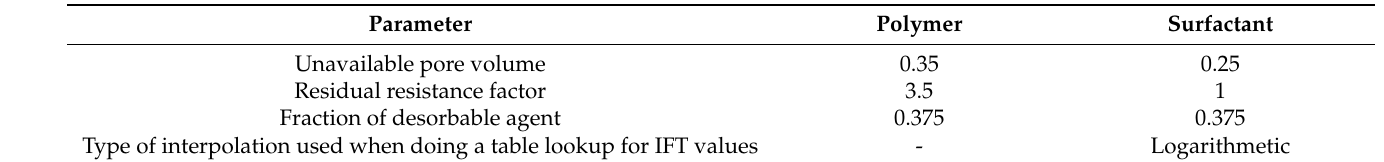
Table 5. Parameters obtained by tuning the model to the experiment.